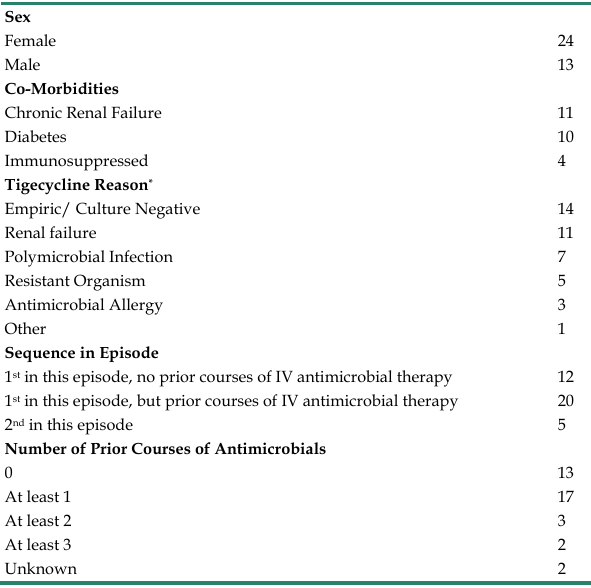
Table 1. Demographics and Antimicrobial Details. Sex